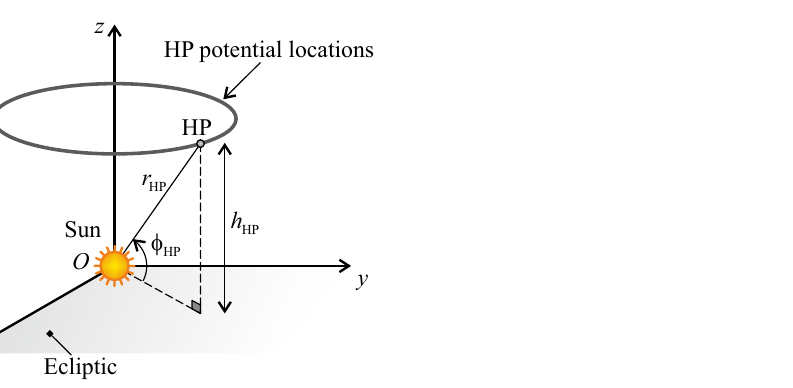
Figure 2. HP potential locations, as a function of { r HP , φ HP } , in the heliocentric-ecliptic refer- ence